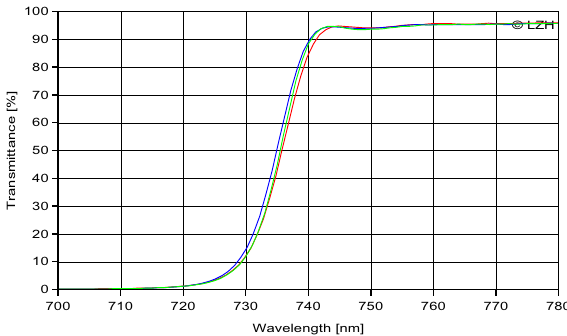
Fig. 3. Measured performance of the coating on the lens. Measurement was done on witness samples. Each sample is viewed at its specific